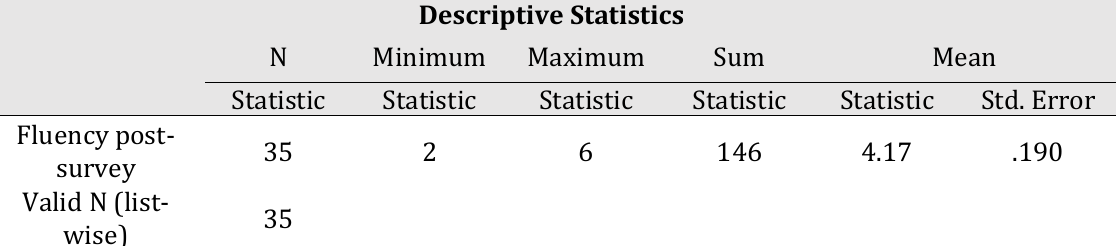
Table 16. Mean Point of Learners’